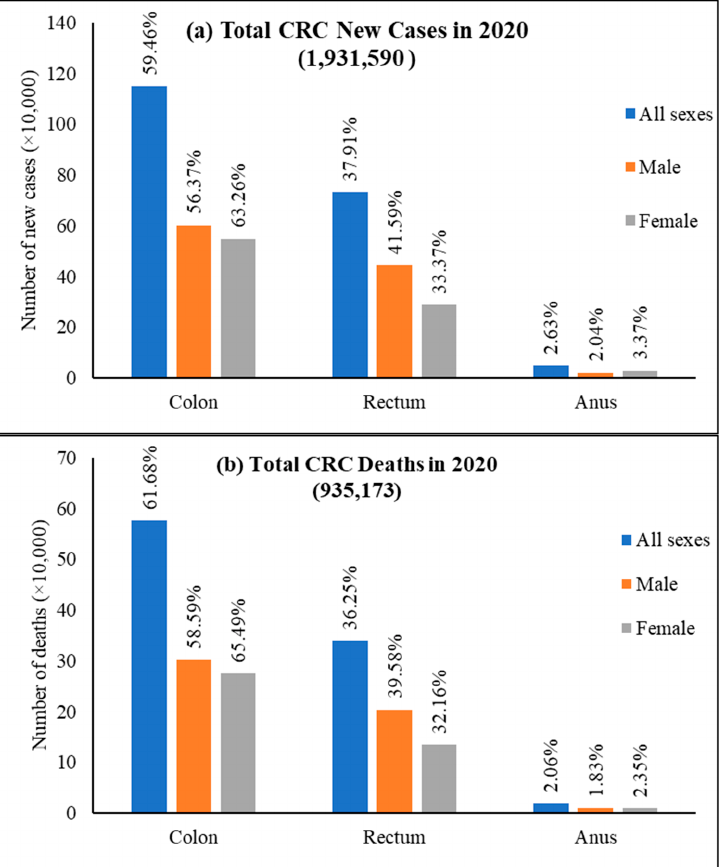
Figure 5. World new cases and deaths of colon cancer, rectum cancer, and anus cancer in 2020. ( a ) New cases and ( b ) deaths of colon cancer, rectum cancer, and anus cancer. The value is shown in % on top of each column and is calculated against the CRC number in 2020 for both sexes and all ages. Data extracted from GLOBOCAN [25] with permission.